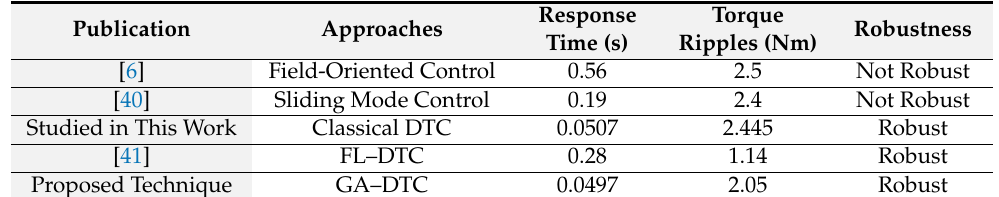
Table 5. Comparison between our proposed approach and some control strategies published